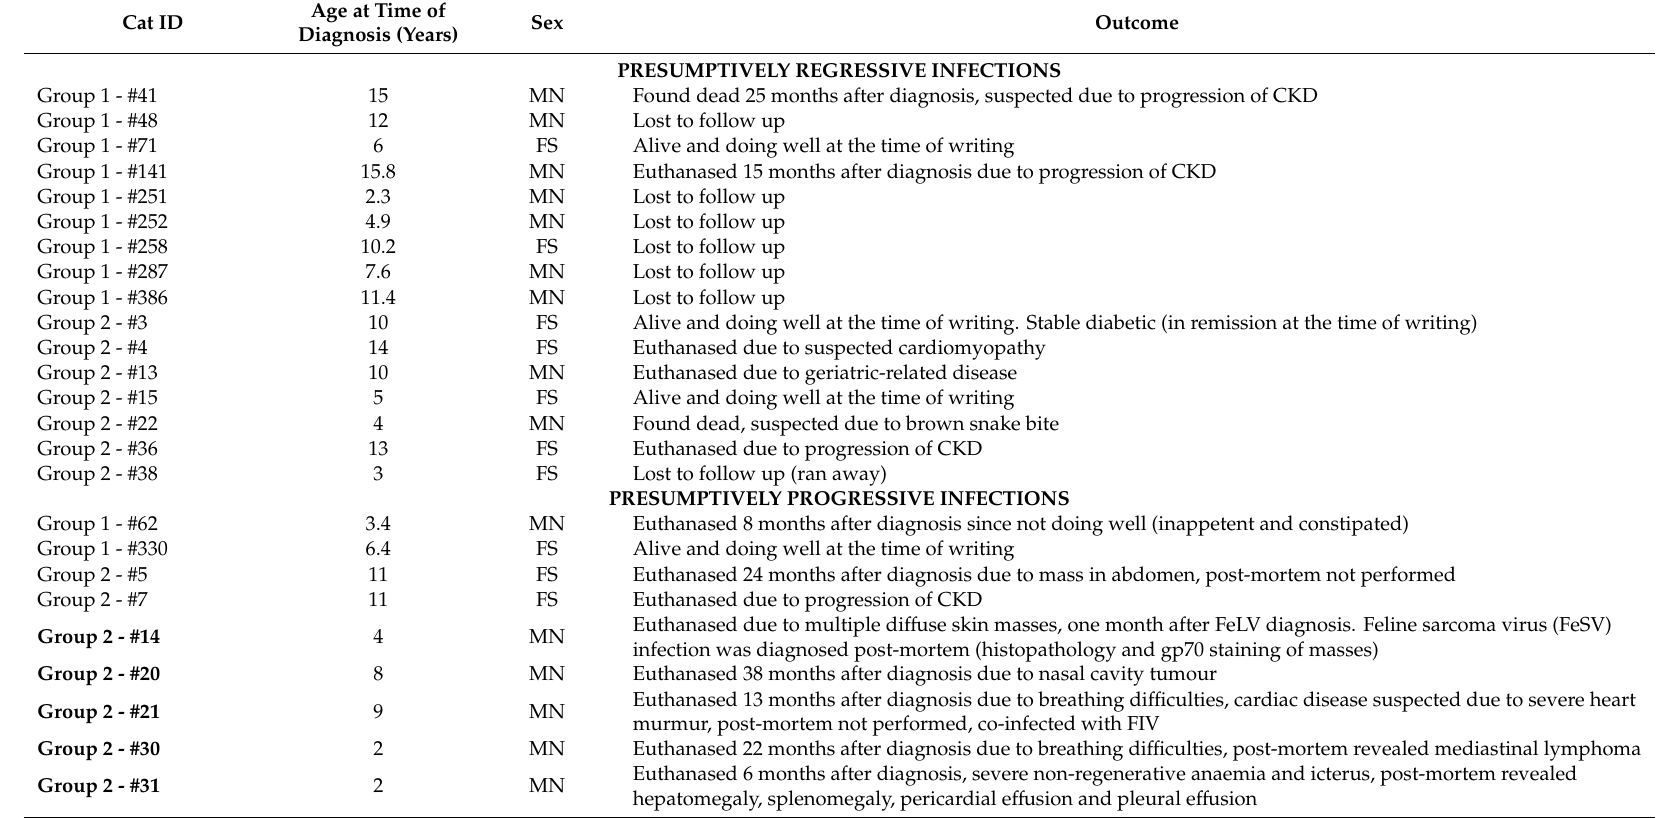
Table 5. Outcomes of FeLV-infected cats in Groups 1 and 2 at the time of writing. All were non-pedigree cats except for #141 in Group 1 that was a Tonkinese, #258 in Group 1 that was a Chinchilla and #4 in Group 2 that was a Birman. Due to the field nature of the study, it is not known how long cats had been infected for at the time of diagnosis. When known, the time elapsed between diagnosis and final outcome is noted. The approximate time between diagnosis and manuscript writing was 4–6 years. MN = male neutered, FS = female spayed, CKD = chronic kidney